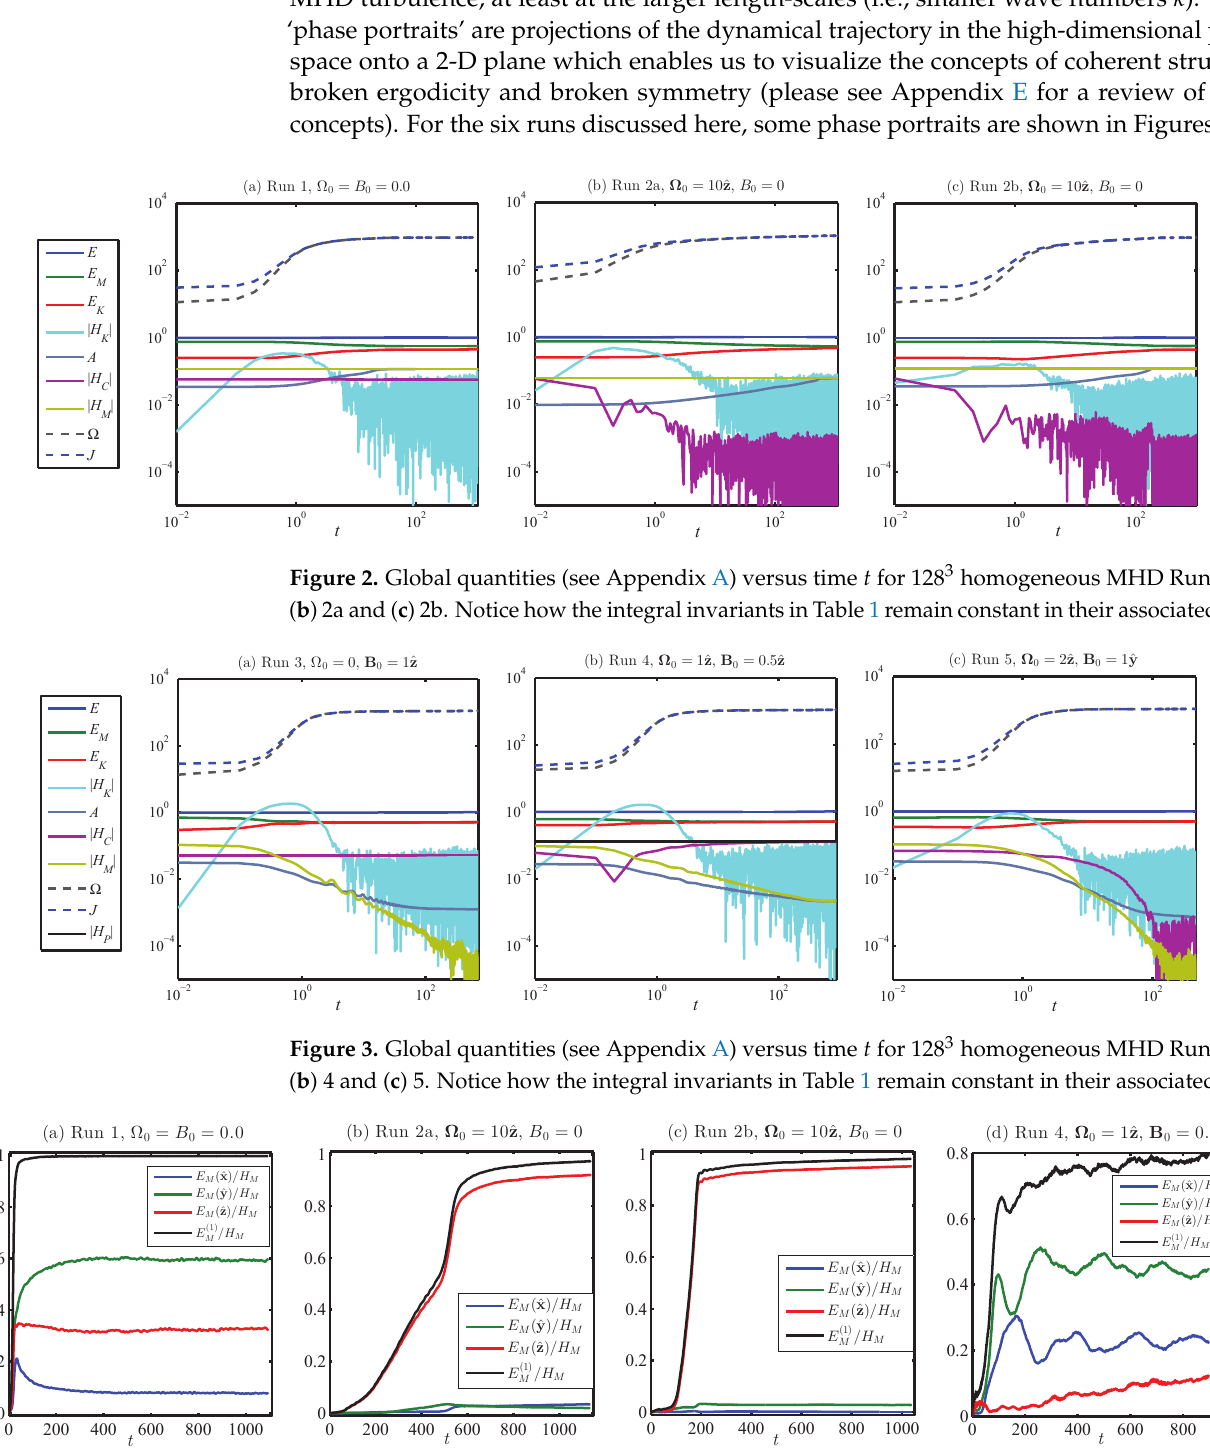
Figure 4. Magnetic energies for the k = 1 modes, normalized by H M > 0, versus time t for Runs ( a ) 1, ( b ) 2a, ( c ) 2b and ( d ) 4. Notice how the total magnetic energy for k = 1, E ( 1 ) H avg for Run 4 from Table 2 is M